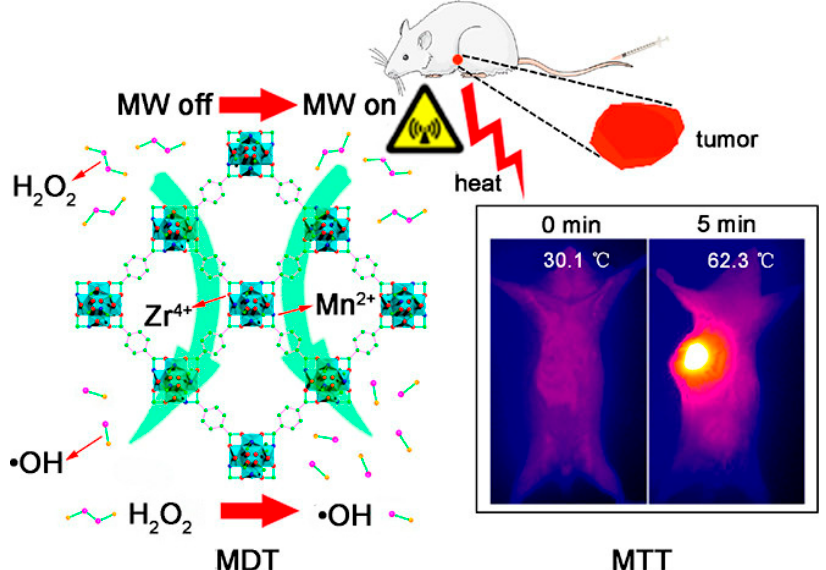
Figure 3. Mn-Zr MOF generates abundant ROS of · OH and a high microwave thermal conversion efficiency after exposure to MW irradiation, resulting in efficiently inhibiting the cancerous cell growth through the synergic effect of MDT and MTT. Reprinted with permission from Ref. [55]. Copyright 2018, American Chemical Society.